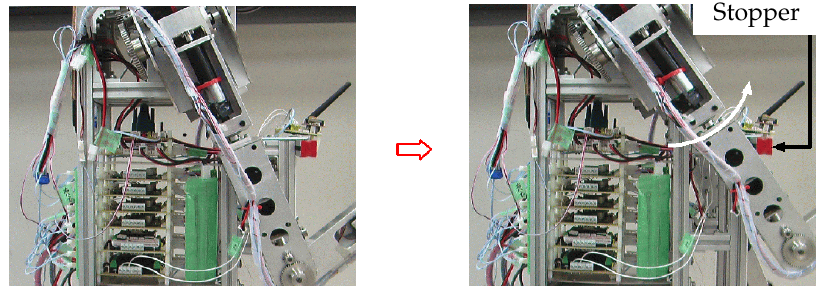
Figure 9. Limit of manipulator rotation when the robot is being pulled.